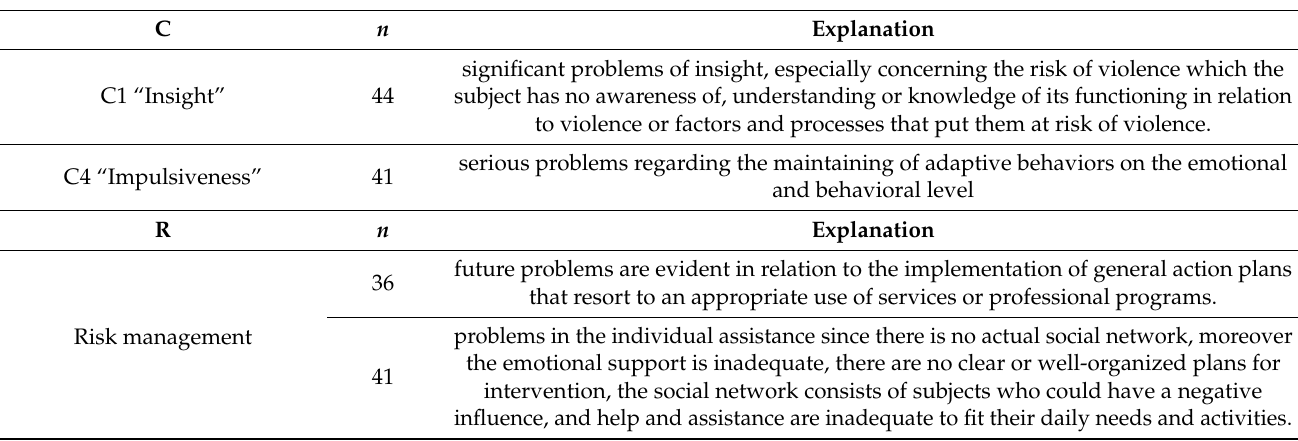
Table 2. HCR20v3 items resulted significant.